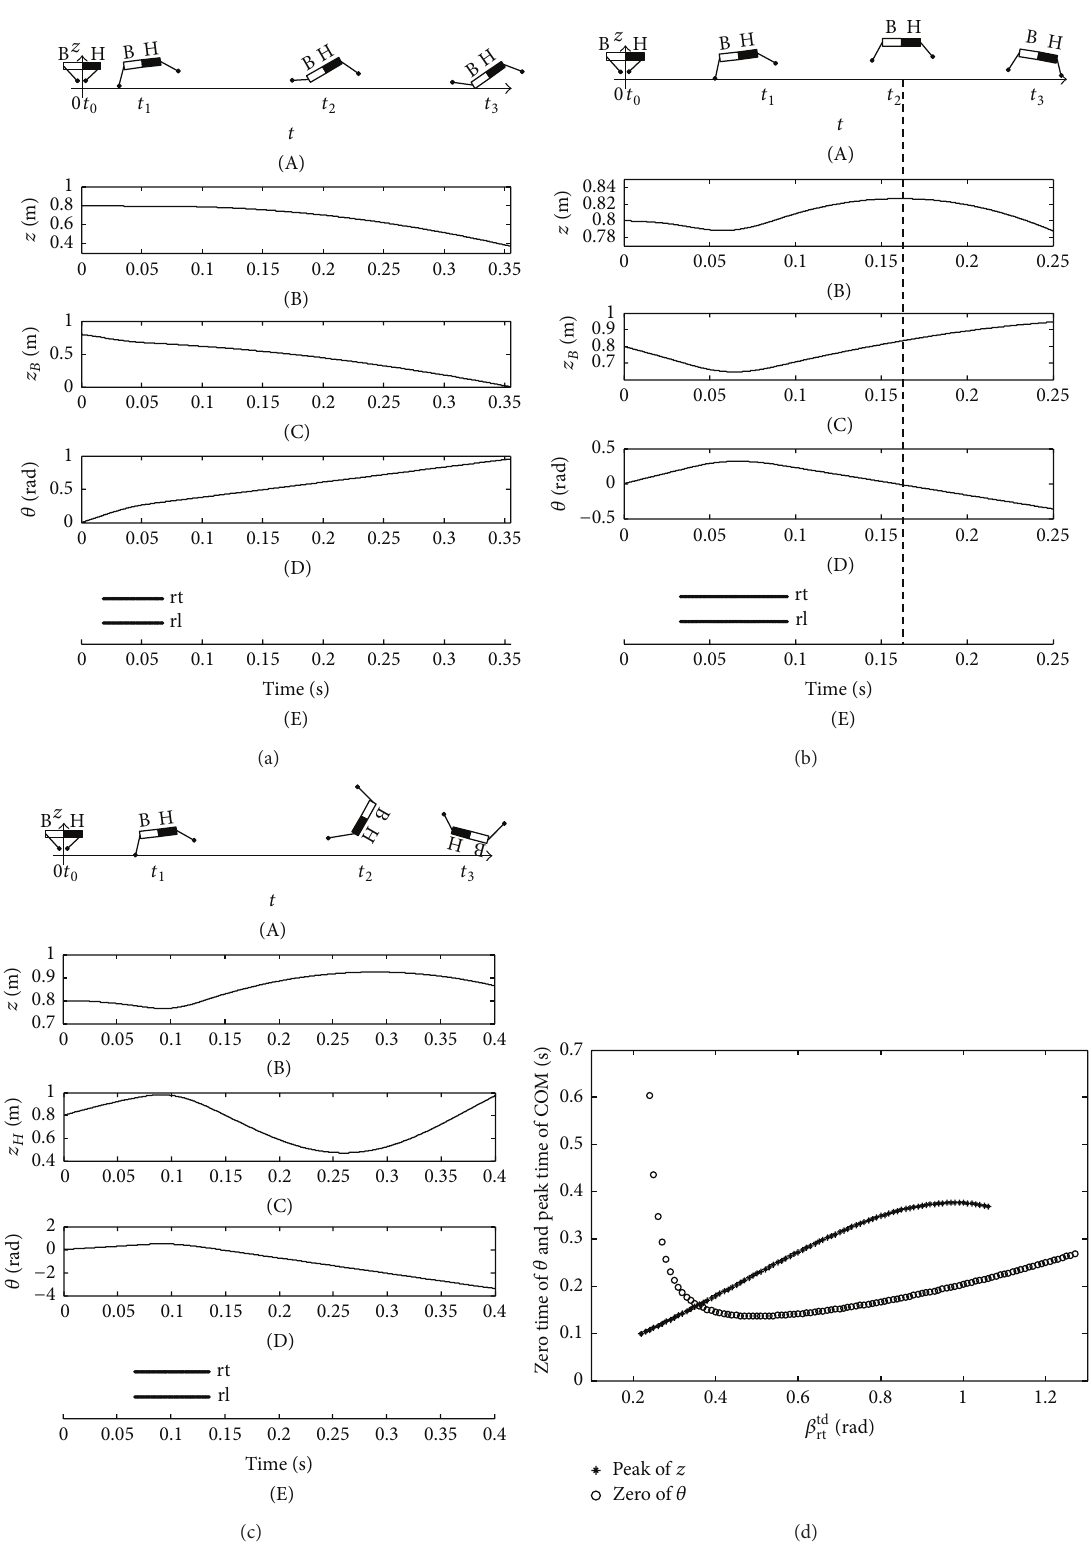
Figure 16: Imbalance and balance postures of lion. (a) The imbalance posture when 𝛽 td rt = 0 . 12 rad; (b) the balance posture when 𝛽 td rt = 0 . 36 rad; (c) the imbalance posture when 𝛽 td rt = 0 . 64 rad; (d) the zero time of pitching angle and the peak time of